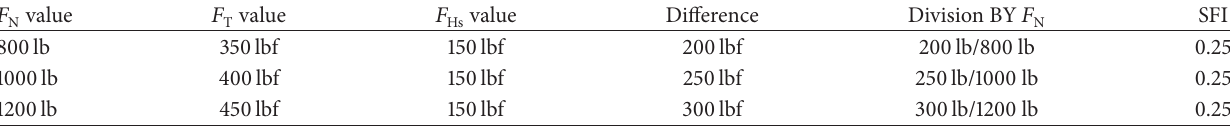
Table 8: Calculation of the sliding friction index (SFI) using data from TRB locked-wheel